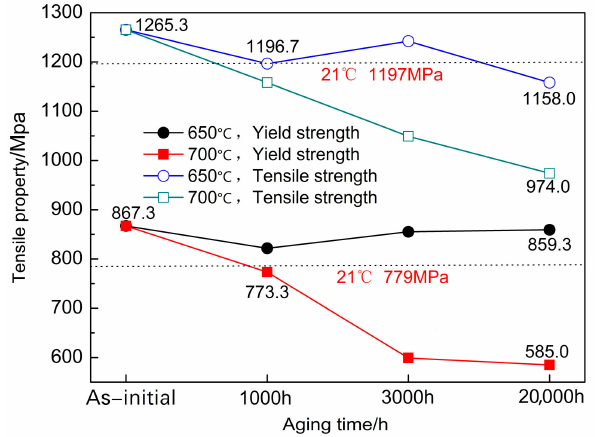
Figure 9. Mechanical properties at room temperature of Inconel 783 alloy bolts for di ff erent aging times and temperatures.